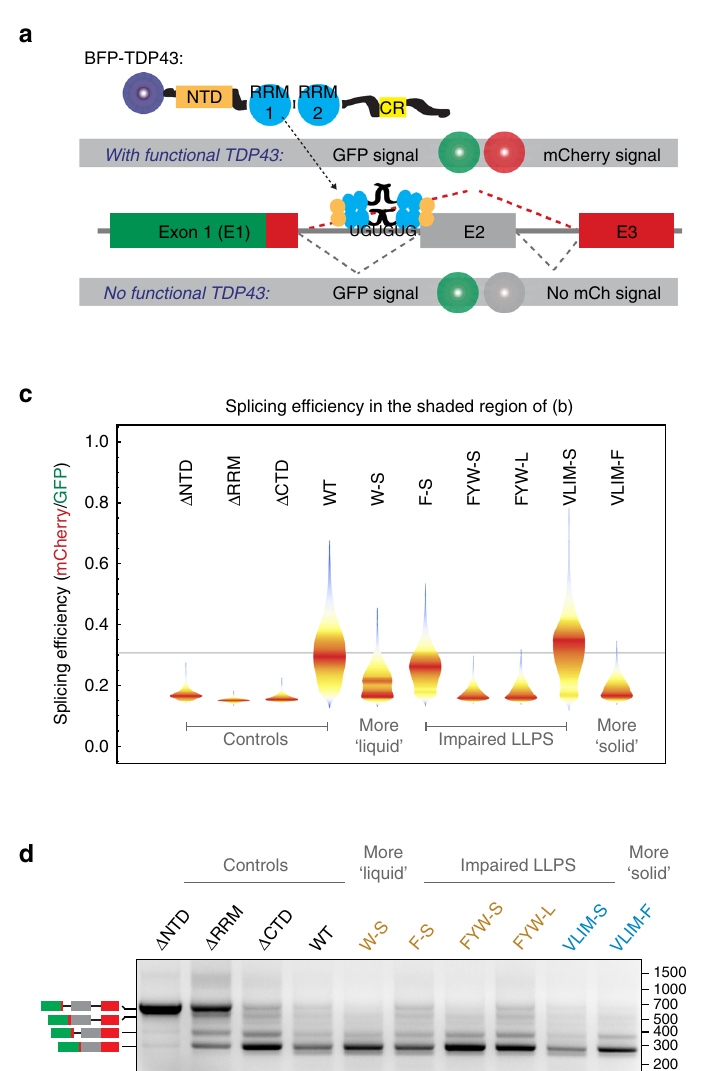
total expression levels of the re-introduced TDP43 (BFP fl uorescence) on a cell-by-cell basis (Fig. 7b). IDR-driven condensation is dispensable for exon skipping . We fi rst used our splicing reporter assay to compare the splicing NATURE COMMUNICATIONS| (2019) 10:4890